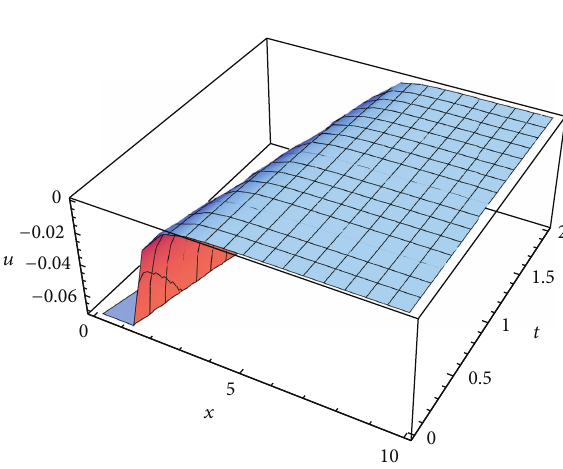
Figure 2: Profile of solution